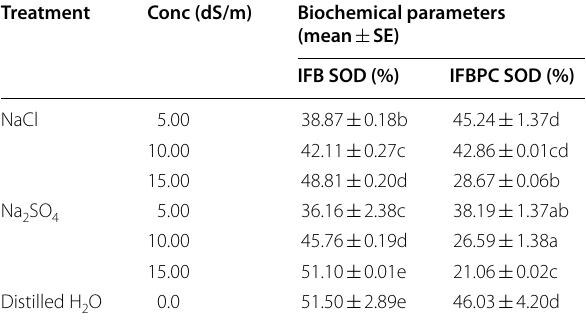
Means followed by different letters in the column are significantly different ( P < 0.05) from one another using Duncan’s new multiple range test